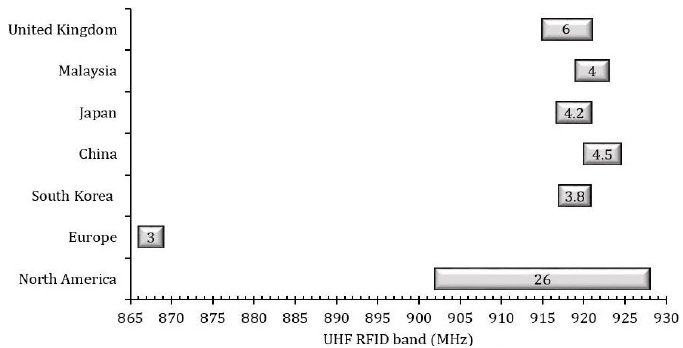
Figure 2. Ultra-high frequency (UHF) radio frequency identification (RFID) band (865–930 MHz) standards of different countries.